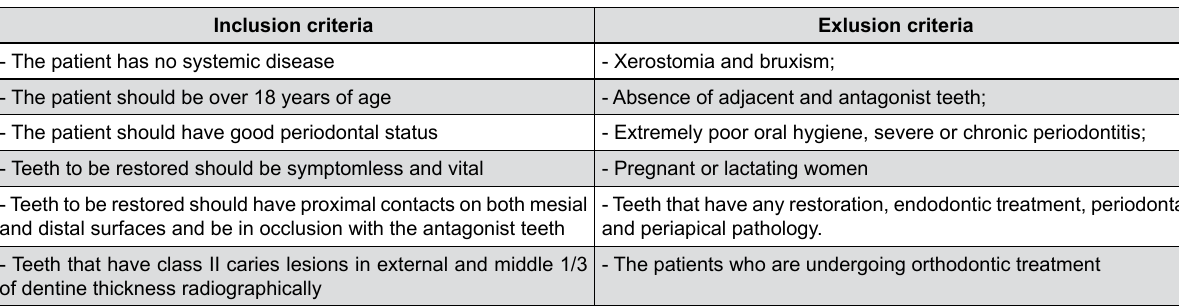
Inclusion criteria